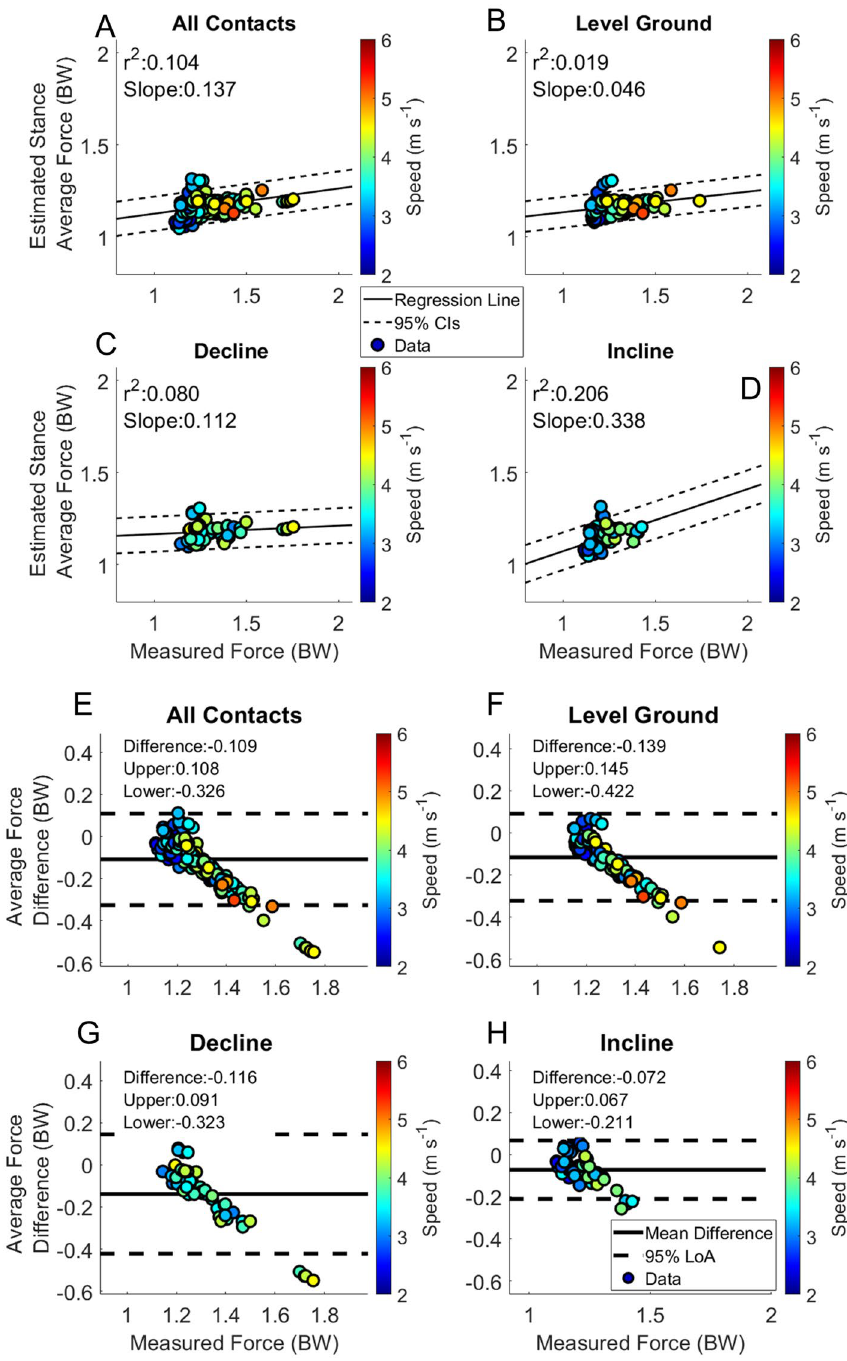
Figure 6. Stance average GRF. Linear regression and Bland–Altman plots are presented for all foot contacts ( A and E ), followed by level ground ( B and F ), decline ( C and G ) and incline foot contacts ( D and H ). Pearson Correlation Coefficients and the slope of the regression line are presented in panels ( A – D ). The Bland–Altman plots present differences between the estimated and measured stance average GRF. The average difference and the 95% LoA are shown in panels ( E – H